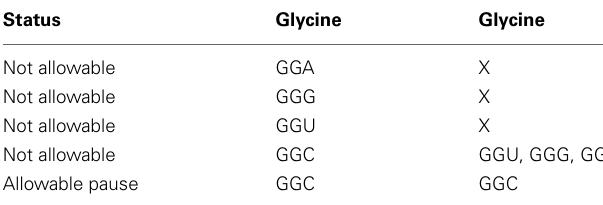
Table 1B | N/A Affinity > 5.0 defined as not